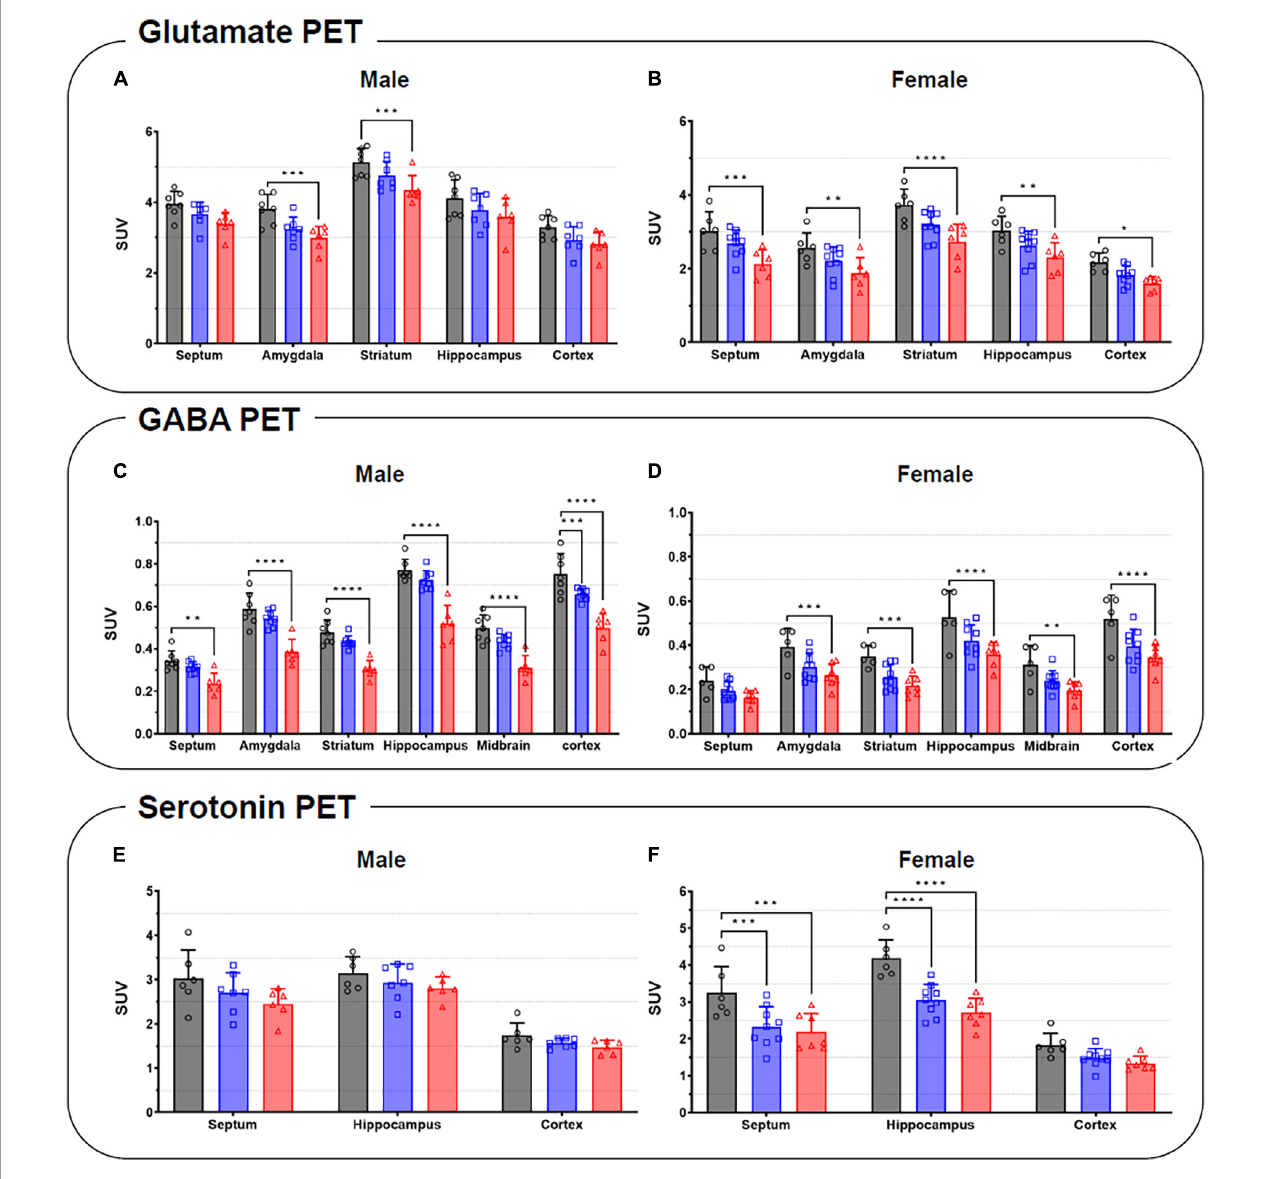
FIGURE6 Quantification of the radioactivities for the glutamate (A,B) , GABA (C,D) , and serotonin PET (E,F) in the specific brain regions in male (left) and female (right). Data are presented as the mean ± the SD ( n = 6). Statistical significance was defined as a p -value less than 0.05 (* p < 0.05, ** p < 0.01, *** p < 0.001, **** p <